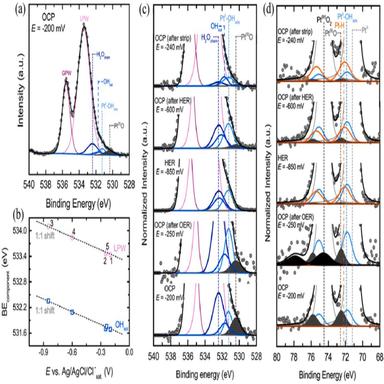
(a) Operando APXPS O 1s photoelectron peak at 4 keV at OCP. The gas phase water (GPW), liquid phase water (LPW), chemisorbed water (H2Ochem), soluble hydroxyls (OHsol), adsorbed hydroxyls (Ptδ − OHads), and oxidized platinum (Pt(II)O) features are noted. (b) The BE of solution species LPW and OHsol shift 1:1 with applied potential, while species on the surface remain fixed. (c) Magnification of the O 1s, background subtracted and normalized to the intensity of the Pt0 , as a function of applied potential,